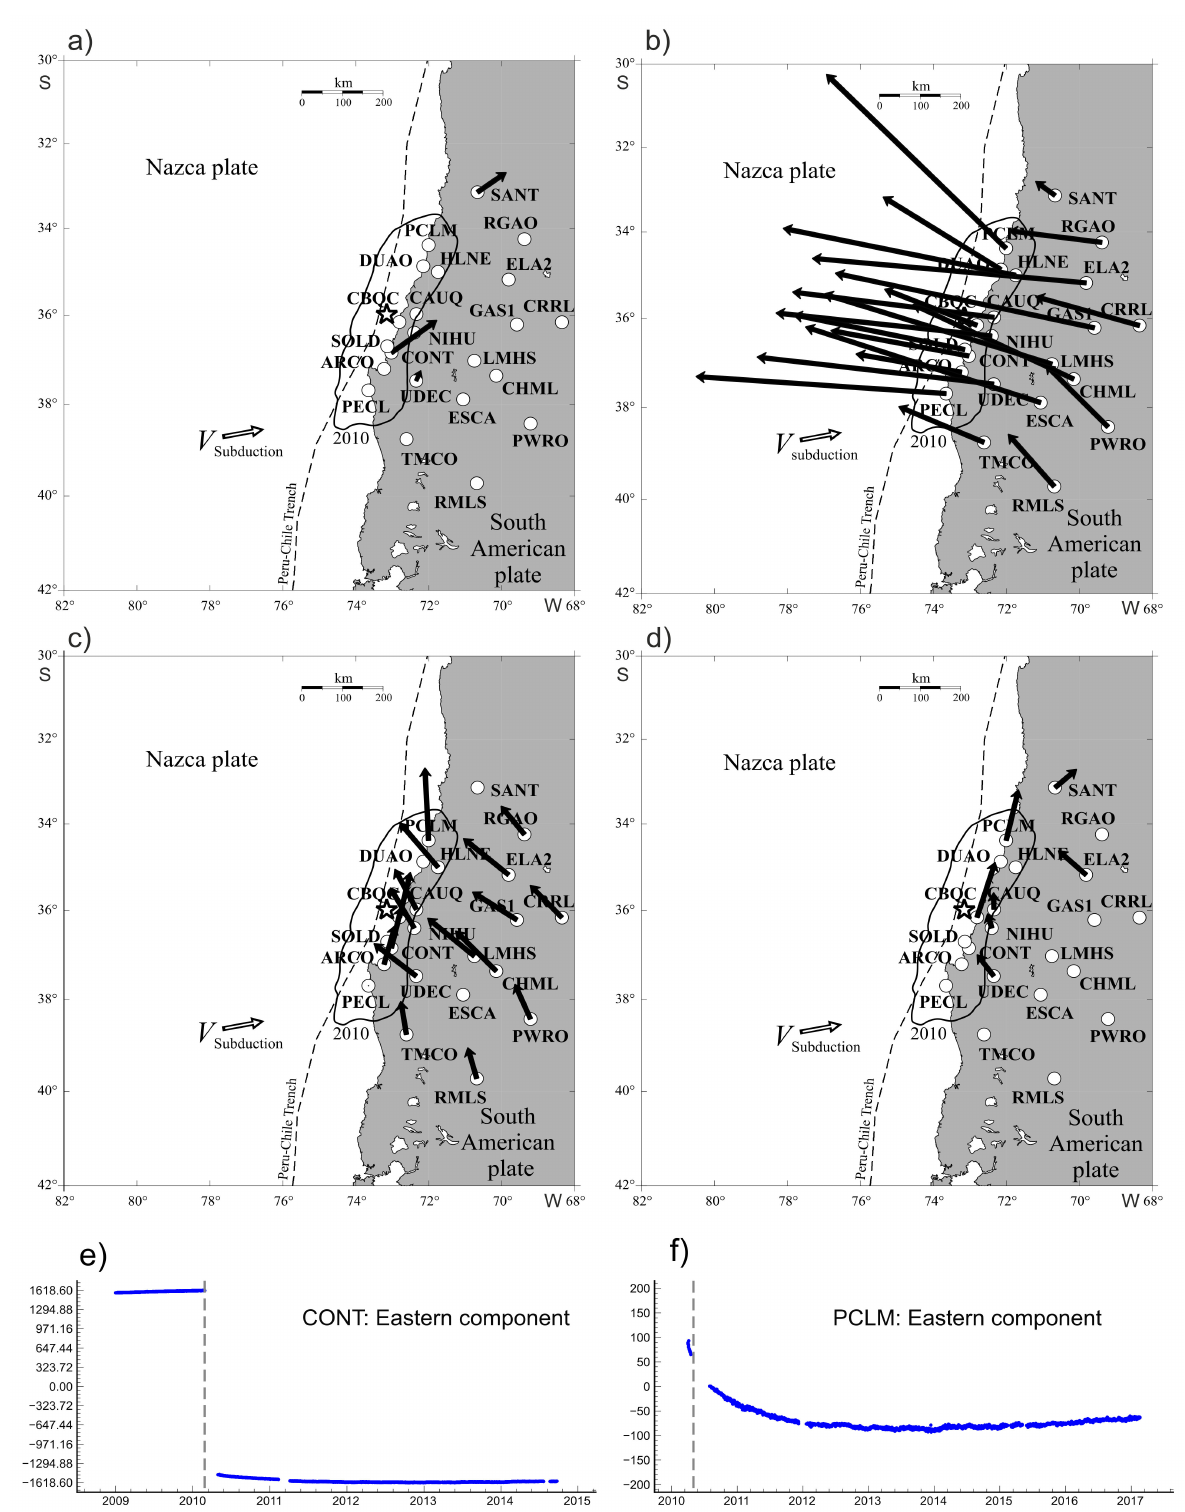
Figure 5. GNSS-observed motions in Chile subduction zone before ( a ) and after ( b , d ) large 2010 Maule earthquake modified from [17]. Map plots show the velocity vectors estimated from the Chilean and Argentinean regional satellite geodesy networks data for the time intervals of 27 February 2009–26 February 2010 ( a ); 28 February 2010–27 February 2011 ( b ); 28 February 2013–27 February 2014 ( c ); and 28 February 2016–27 February 2017 ( d ). Lower panel shows eastward displacement timeseries measured at CONT ( e ) and PCLM ( f ) GNSS stations. Displacements are relative to the South American lithospheric